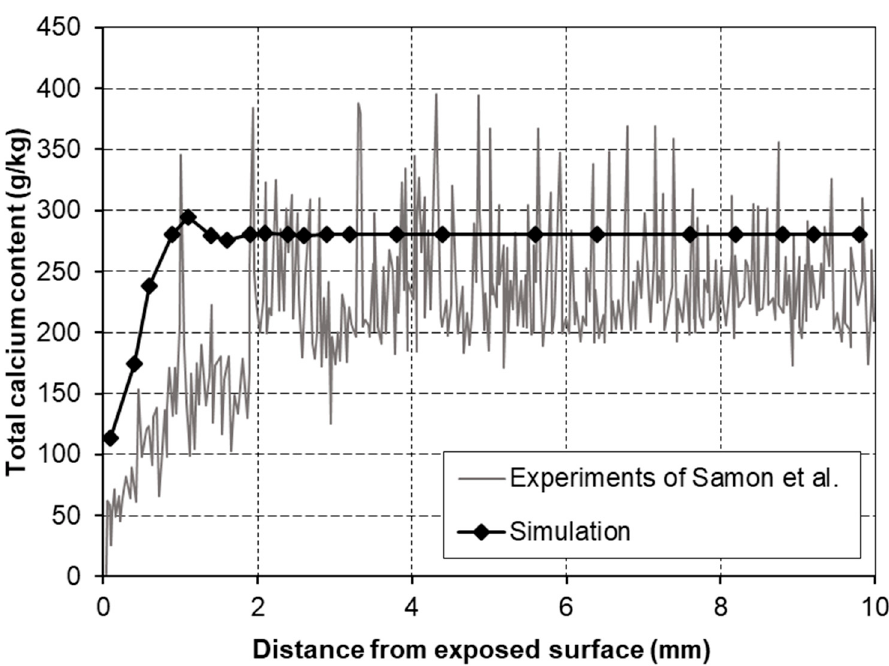
Figure 2. The experimental and simulated profiles of calcium distribution.